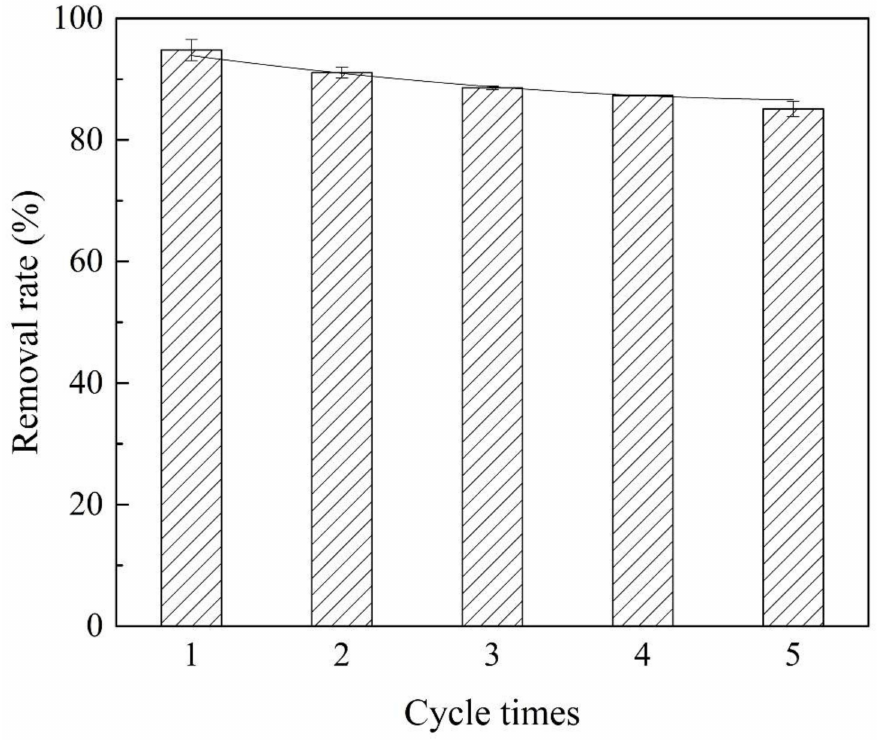
Figure 7. Cycle experiments of Co@AC (Co@AC dosage 180 mg/L, atrazine concentration 10 mg/L, the solution pH 4.0, reaction time 180 min, reaction temperature 25 ◦